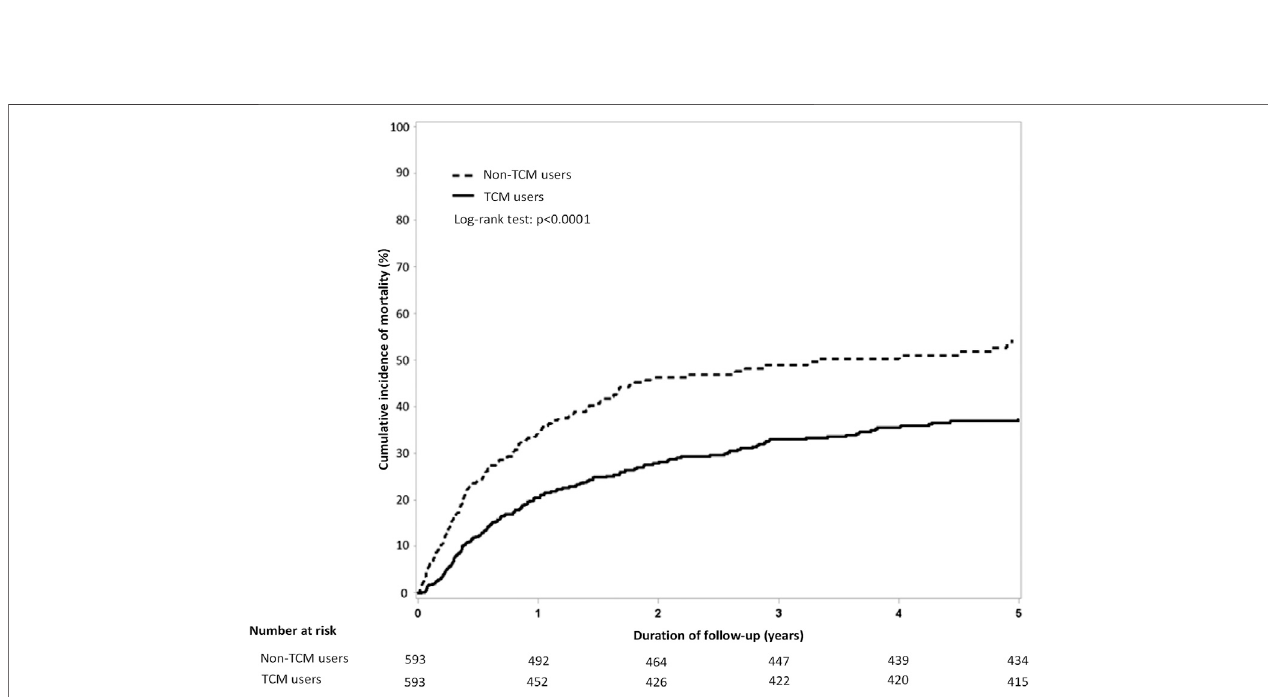
FIGURE 4 | Comparison of cumulative incidence of mortality among chemotherapy users who did and did not use TCM. Abbreviations: TCM, traditional Chinese medicine.